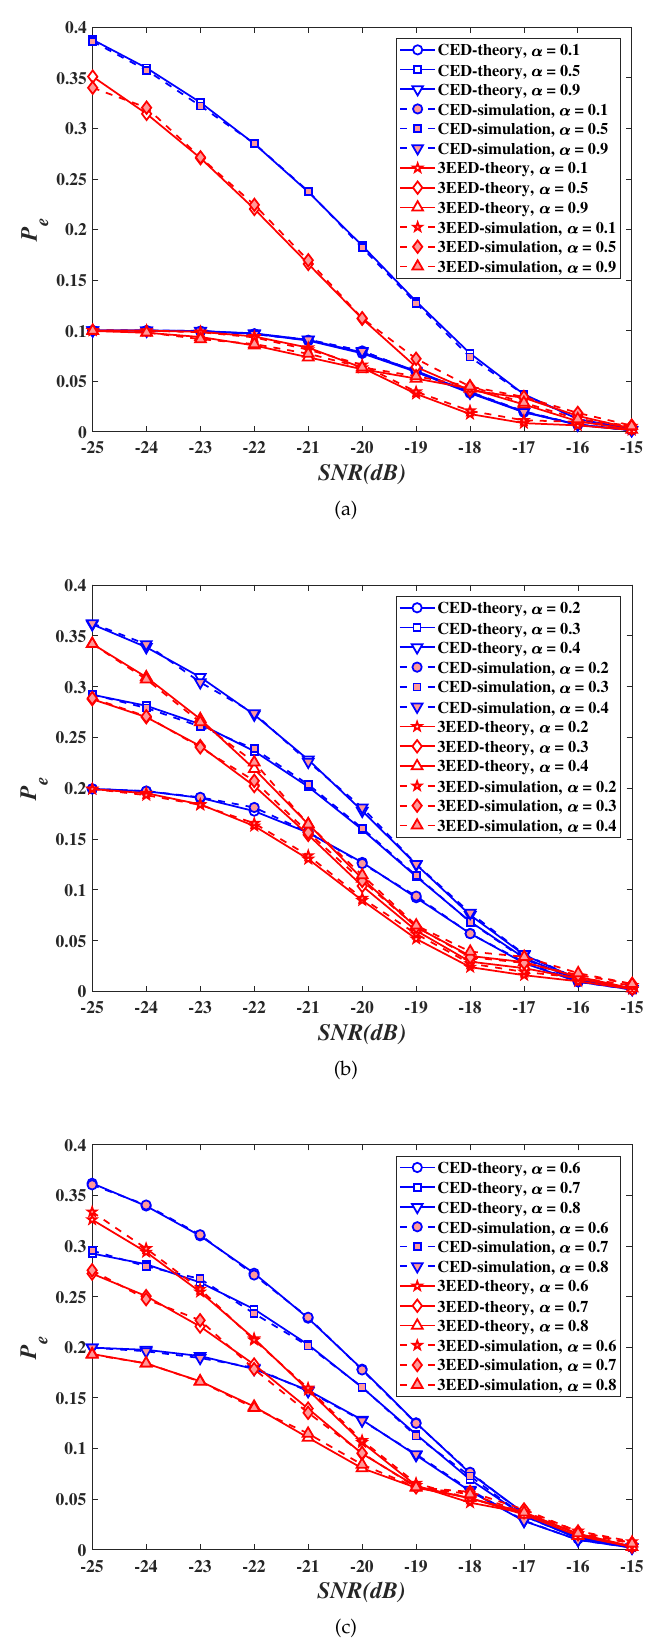
Figure 2. Decision error probability (DEP) for adaptive algorithms as a function of signal-to-noise ratio (SNR). ( a ) α = 0.1,0.5, and 0.9; ( b ) α = 0.2,0.3, and 0.4; ( c ) α = 0.6,0.7, and